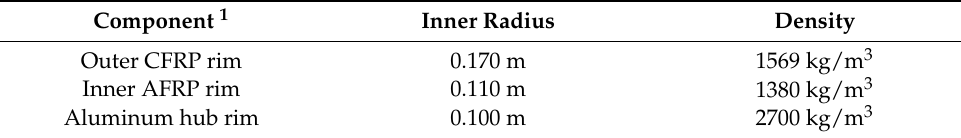
Table 1. Flywheel rotor dimensions and material